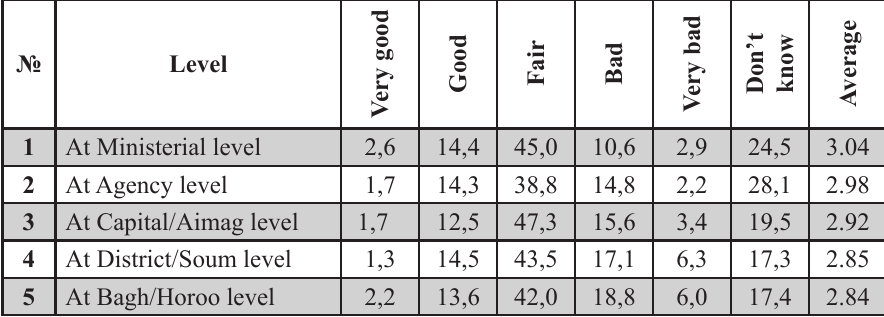
Table 10. How do you evaluate activities of state institutions at different levels?